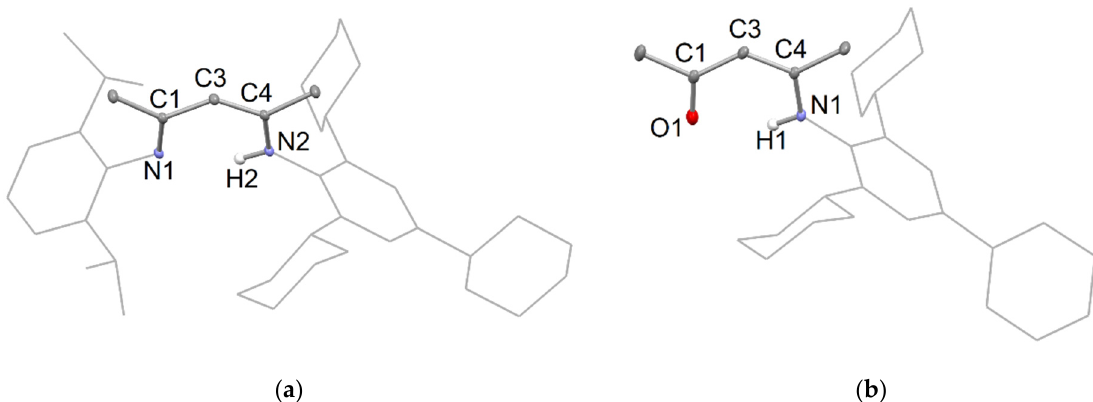
Figure 1. ( a ) Partial thermal ellipsoid plot (25% probability surface for displayed ellipsoids) of the molecular structure of 2 (hydrogen atoms, except H2, omitted; Dip and TCHP groups shown as wireframe for clarity). Selected bond lengths (Å) and angles (°): N(1)-C(1) 1.317(2), C(1)-C(3) 1.419(2), C(3)-C(4) 1.391(2), N(2)-C(4) 1.337(2), N(1)-C(1)-C(3) 121.09(14), C(1)-C(3)-C(4) 126.12(14); ( b ) thermal ellipsoid plot (25% probability surface) of the molecular structure of 3 (hydrogen atoms, except H1, omitted; TCHP group shown as wireframe for clarity). Selected bond lengths (Å) and angles (°): O(1)-C(1) 1.239(2), C(1)-C(3) 1.420(3), C(3)-C(4) 1.381(2), N(1)-C(4) 1.342(2), O(1)-C(1)-C(3) 123.14(17), C(1)-C(3)-C(4) 123.61(17).